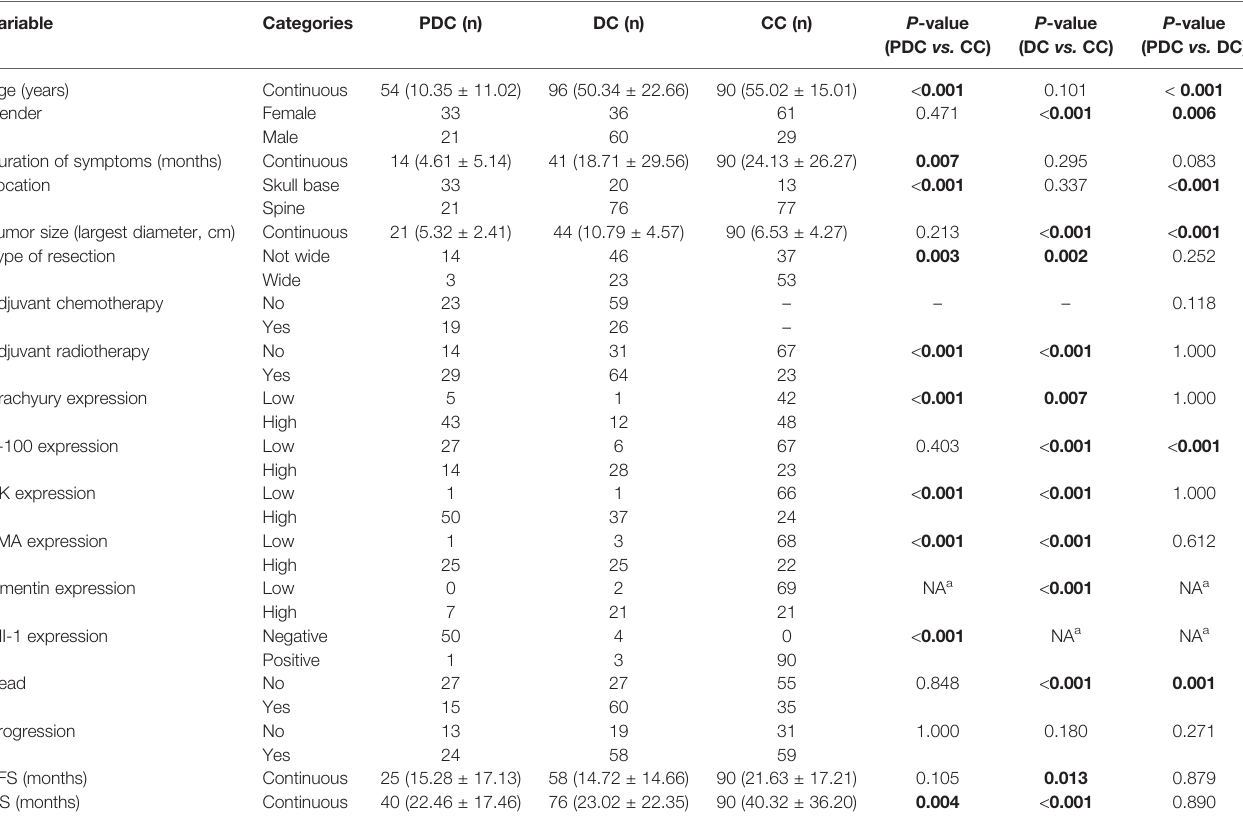
TABLE 1 | Comparison of baseline characteristics among patients with classic chordoma (CC, n = 90), dedifferentiated chordoma (DC, n = 96) and poorly differentiated chordoma (PDC, n = 54).